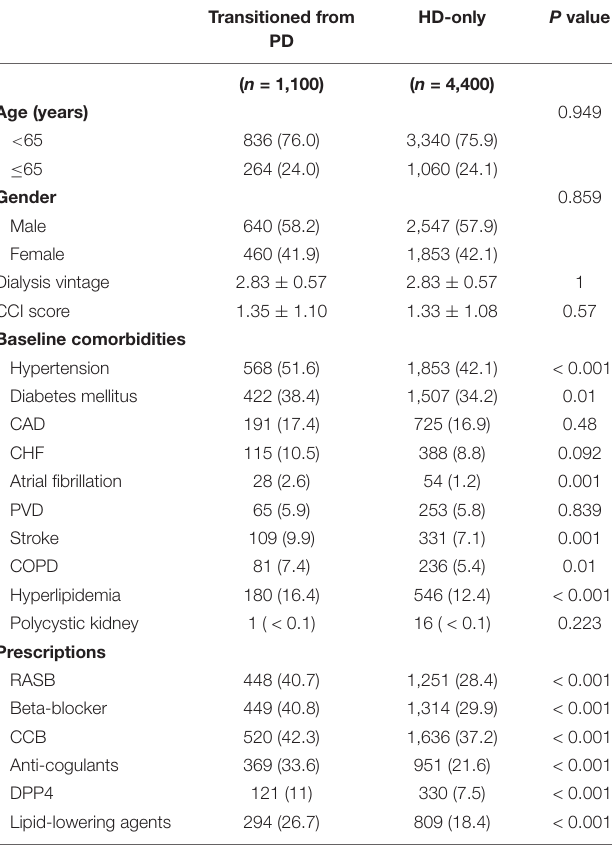
TABLE 1 | Baseline characteristics of study population on hemodialysis after